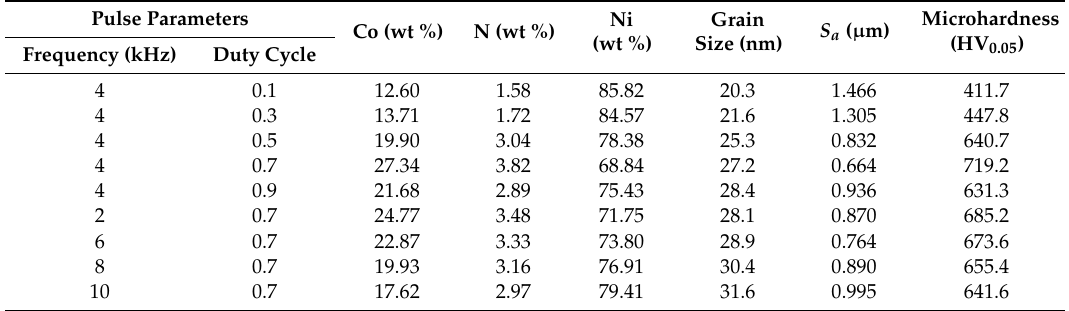
Table 2. Partial data of Ni–Co–BN (h) nanocomposite coatings with varying pulse parameters. Pulse Parameters Grain Ni Co (wt %) N (wt %) (wt %)